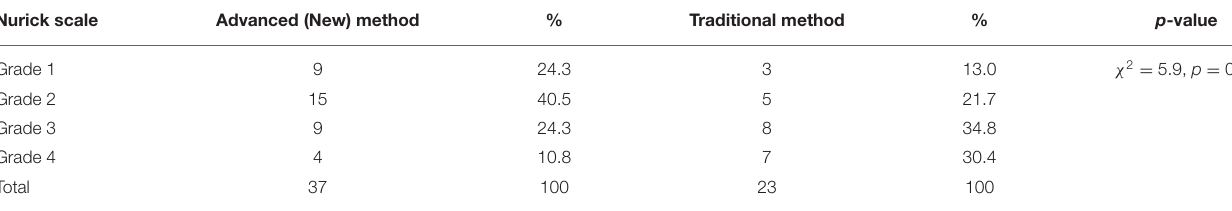
TABLE 3 | Results of surgical treatment of intramedullary tumors. Nurick